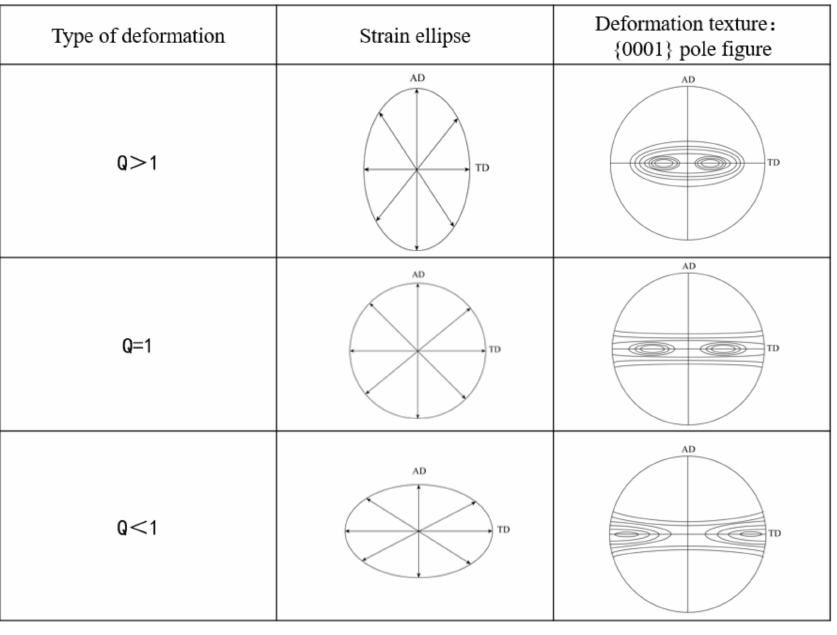
Figure 7. Effect of rolling mode on texture of